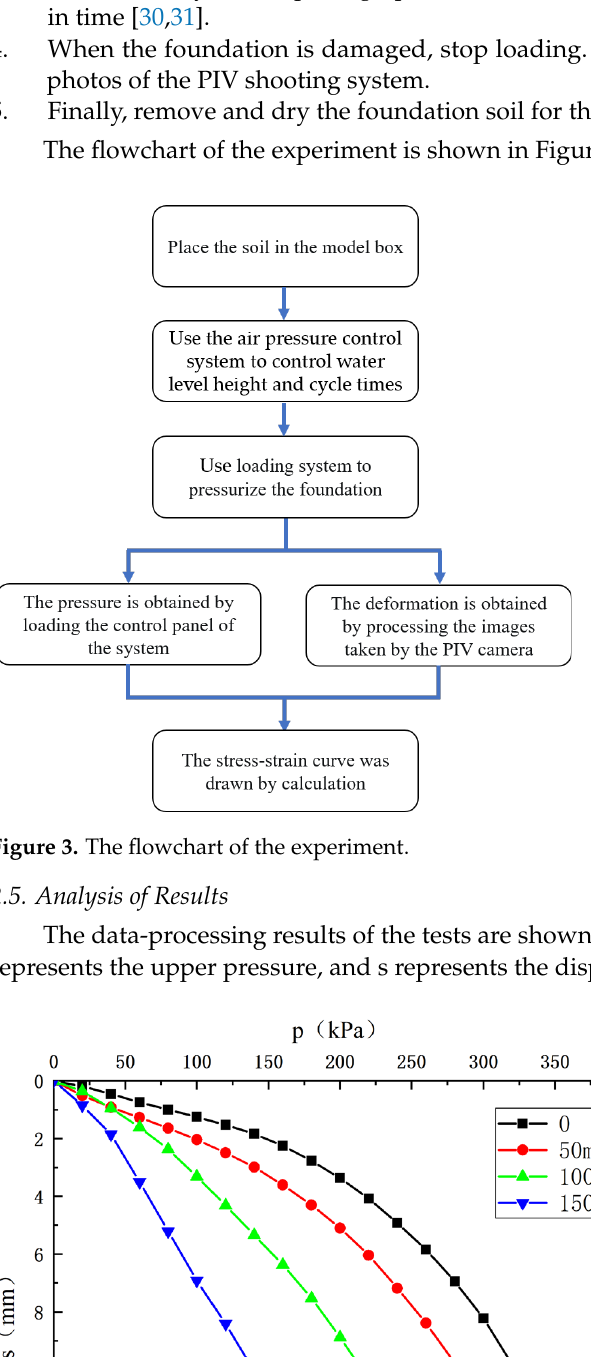
Figure 5. The p–s curves under different cycles.